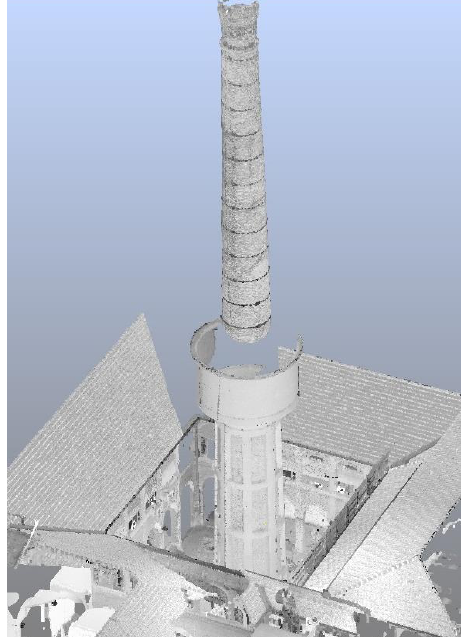
Figure 8. An image of the registered point